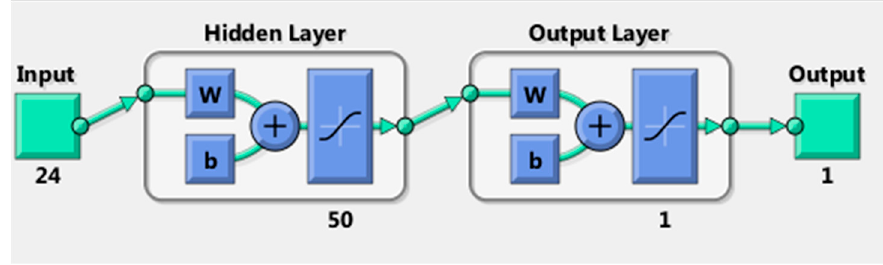
Figure 7. Input data, hidden layer, and output.